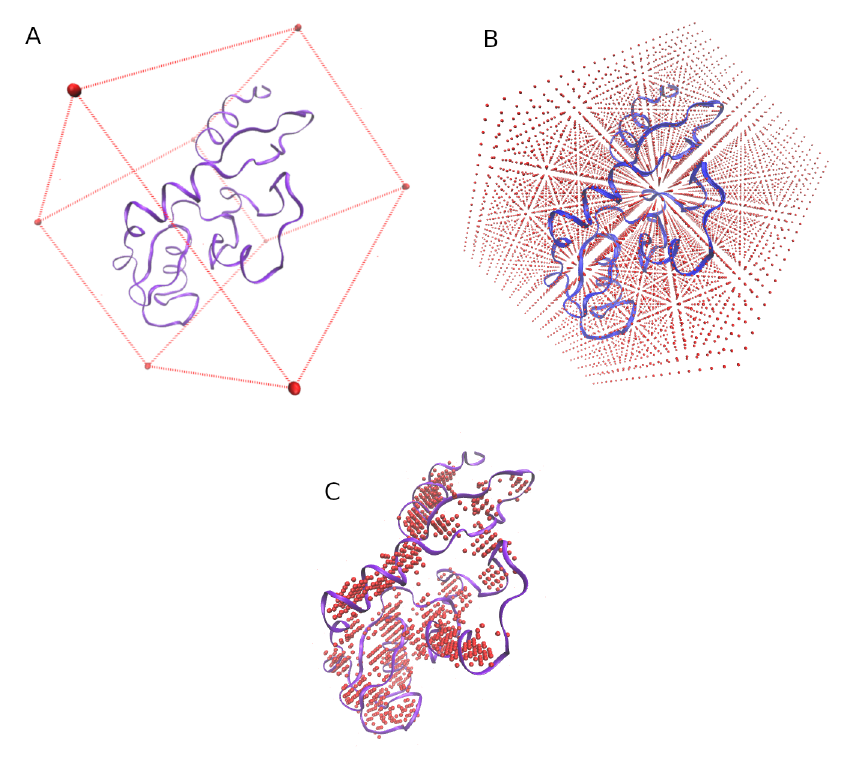
Figure 7. Grid of Virtual Coordinates (GvC). Letters A , B , and C , show the process of creating a Grid of Virtual Coordinates for each protein structure. The red spheres represent the reference coordinates from which the searching of 3D-patterns will be